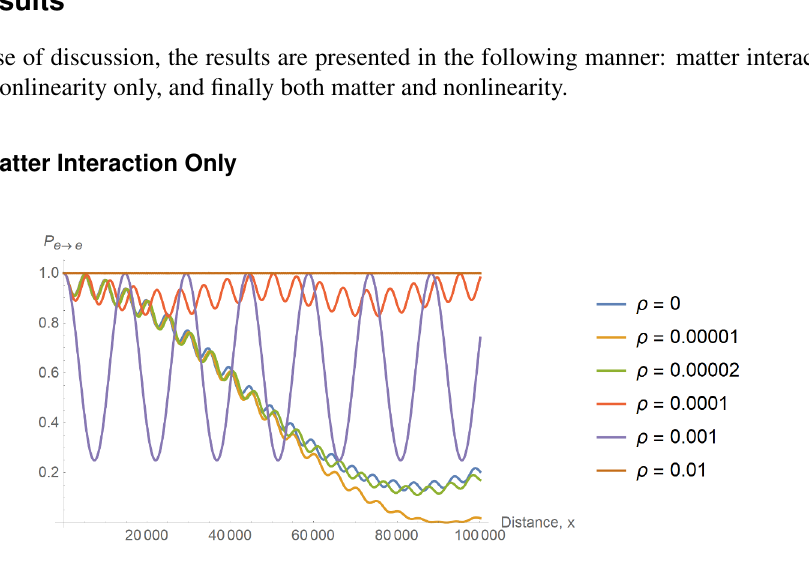
Figure 1. Plot of electron neutrino survival probability, P e → e , as a function of distance, x , for di ff erent background